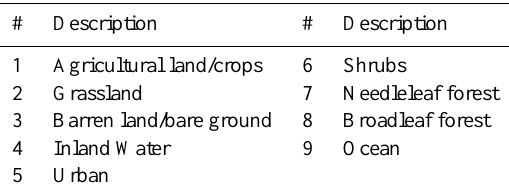
Table 2. Land use categories used in CHIMERE.